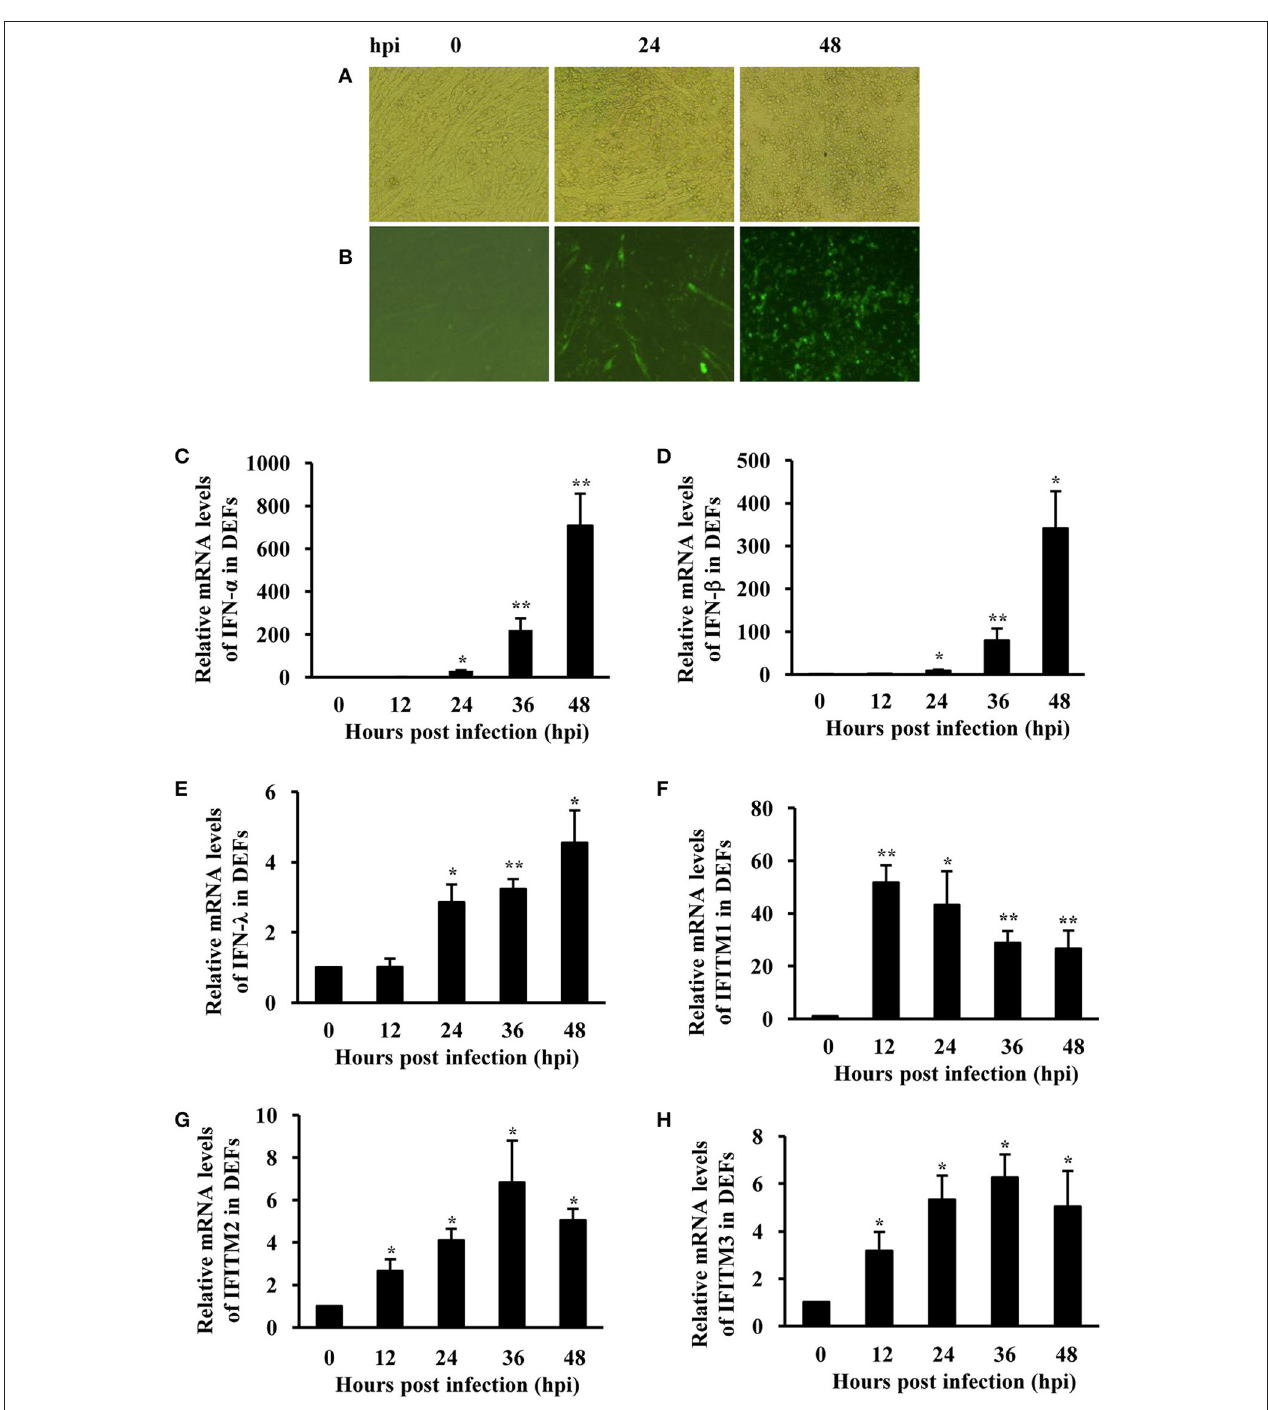
FIGURE 3 | IFNs and IFITMs are significantly induced in DEFs after ATMUV infection. DEFs were infected with or without ATMUV at a MOI of 1.0 and harvested at 0, 12, 24, 36, and 48 hpi, respectively. (A) CPE feature was recorded at 0, 24, and 48 hpi. (B) Viral antigens were detected by IFA in DEF cells at 0, 24, and 48 hpi. qRT-PCR analysis was performed to examine the mRNA expression of duck type I and type III IFNs (C–E) and IFITM1, 2, 3 (F–H) . The mRNA levels were normalized to the endogenous β -actin level and the expression at 0 hpi was set to 1.0. Expression at 12–48 hpi was compared to its expression at 0 hpi. Plotted are the average levels from three independent experiments with three replicates per experiment (means ± SD ). Statistical significance was determined by one tail Student’s t -test analysis. * P < 0.05, ** P < 0.01.